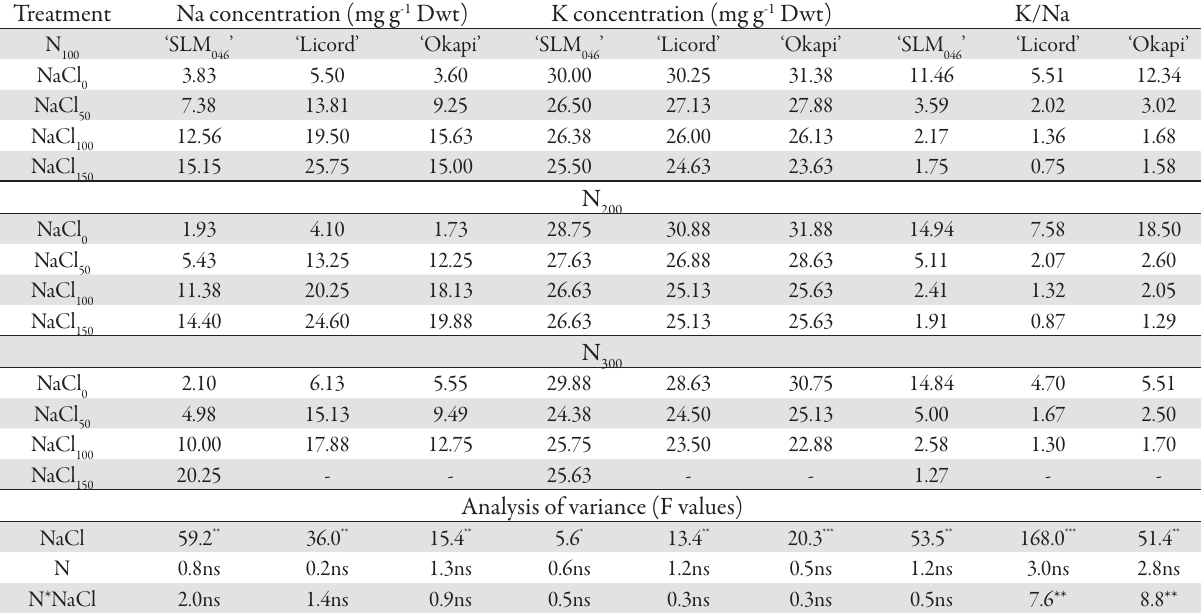
Tab. 3. The effect of salinity and N levels on the vegetative characteristics of canola cultivars Treatment